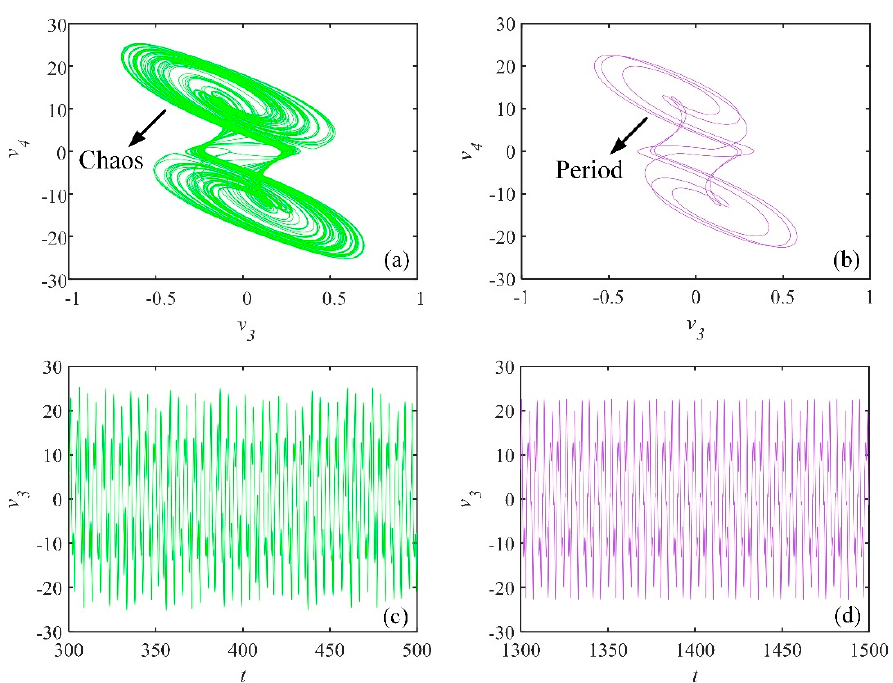
Figure 12. ( a ) Chaos attractor on the v 3 − v 4 plane. ( b ) Period attractor on the v 3 – v 4 plane. ( c ) Time series of v 3 with t (300, 500); ( d ) Time series of v 3 with t (1300,